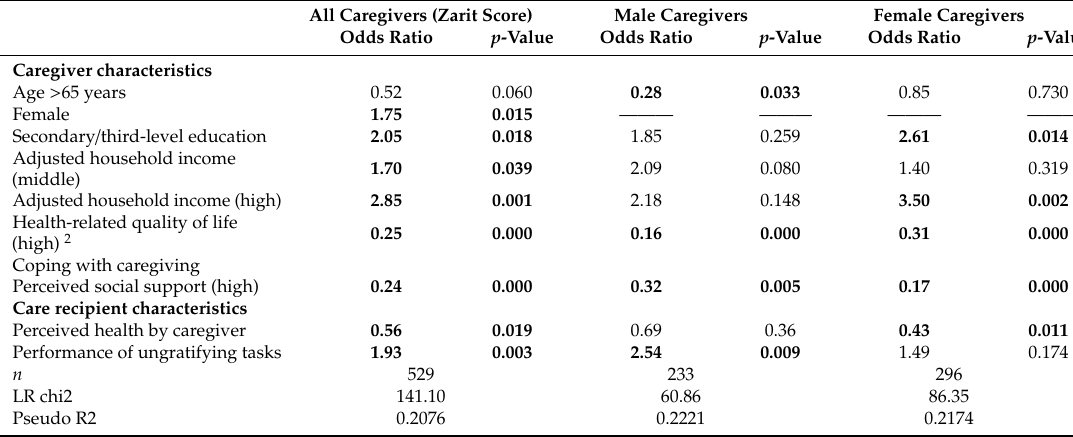
Table 3. Variables associated with informal caregiver intensive burden (Zarit score): multivariate analysis di ff erentiated by gender 1 . All Caregivers (Zarit Score) Male Caregivers Female Caregivers Odds Ratio p -Value Odds Ratio Odds